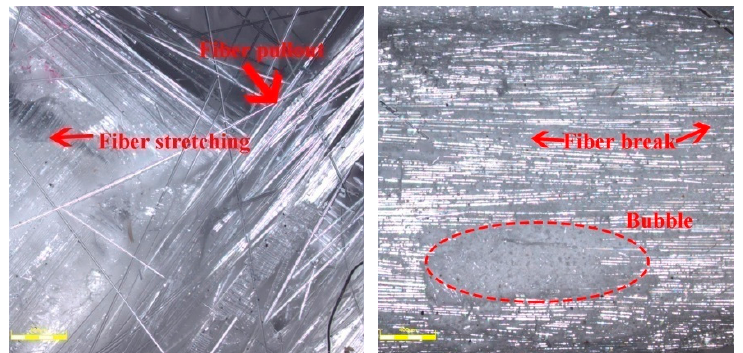
Figure 8. Microscopic experimental setup.